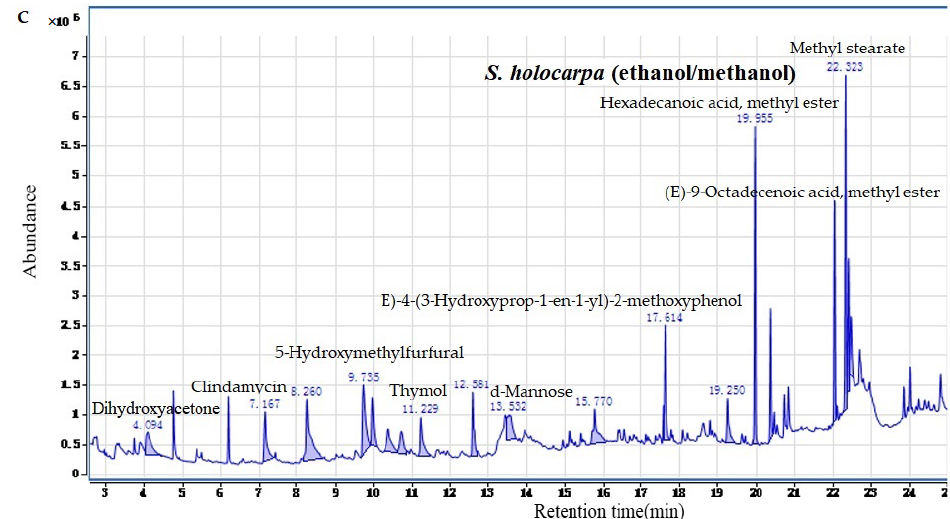
Figure 2. Total ion chromatogram of S. holocarpa (methanol) ( a ), S. holocarpa (benzene/ethanol) ( b ), and S. holocarpa (ethanol/methanol) samples ( c ).